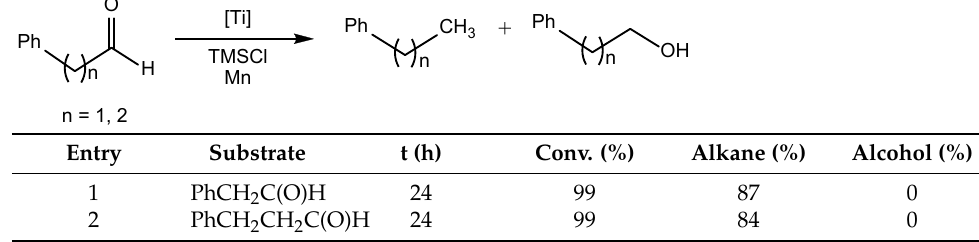
(Table 1, entry 1). A comparison of the results of entries 1, 4, and 5 attests to the importance of temperature in the selectivity in toluene and shows that at 55 °C, the reaction was es- sentially completed after 7 h. The importance of THF as the solvent is likely related to the